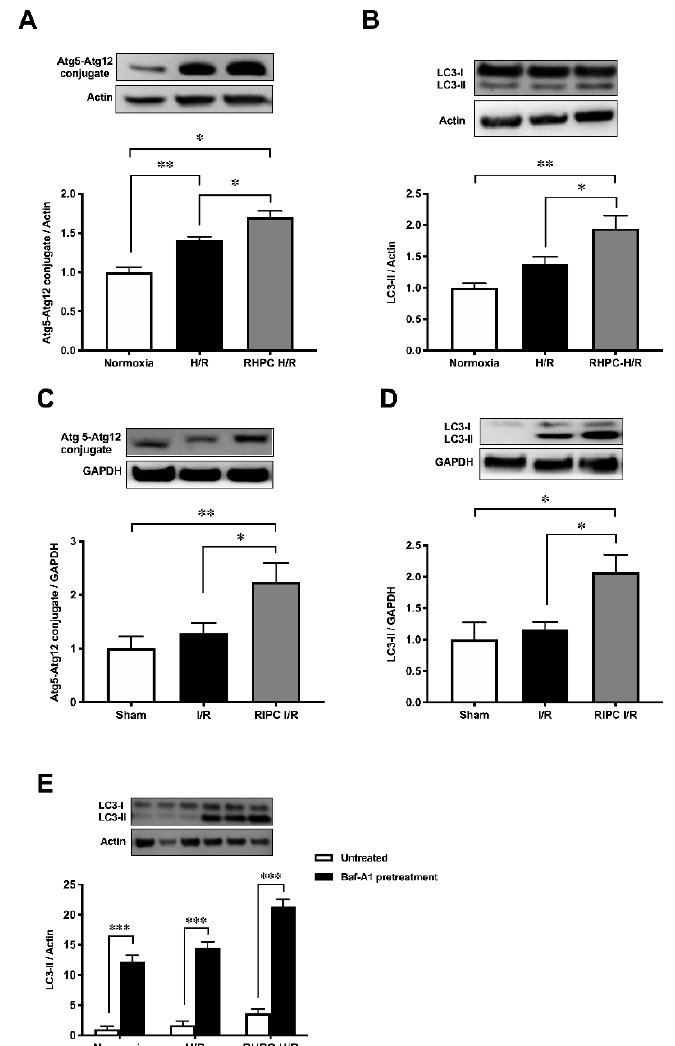
Figure 1. Effect of RIPC prior to I/R on autophagy protein expression in vitro and in vivo . Western blot analysis of Atg5-Atg12 conjugate in ( A ) H9c2 cells, ( B ) rat heart lysate and LC3 protein levels in ( C ) H9c2 cells, ( D ) rat heart lysate, and ( E ) bafilomycin-A1-treated H9c2 cell extracts, expressed as mean ± SEM, fold relative to control; * p < 0.05, ** p < 0.01.